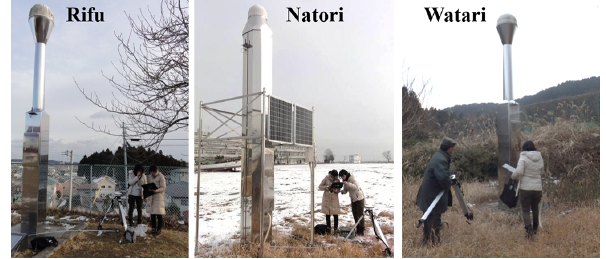
Figure 2. Photos of different types of GNSS-based ground control stations taken during the field surveys of the study area.